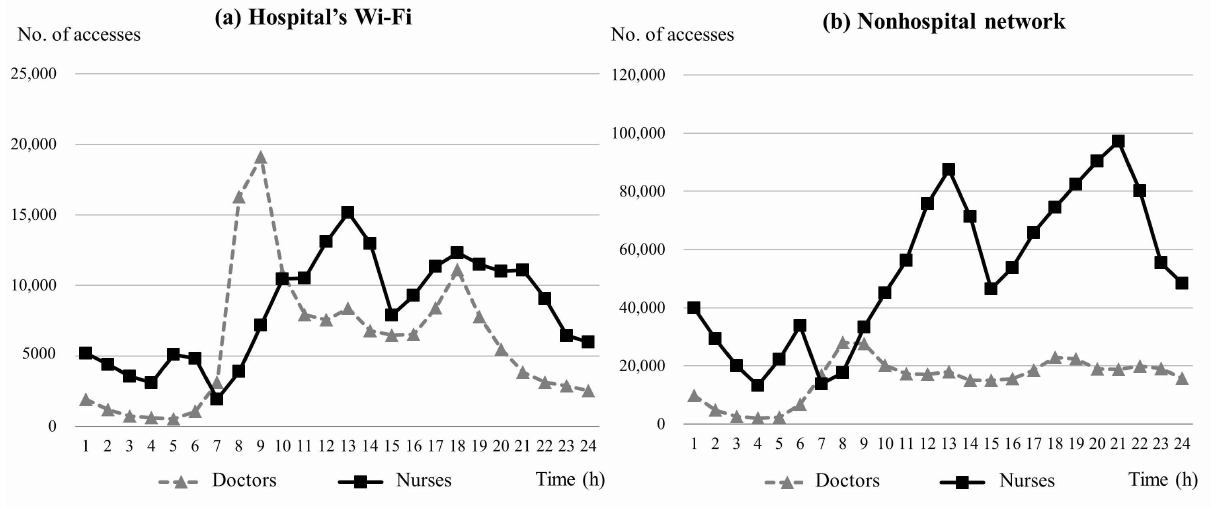
Figure 5. Network access frequency according to time and user’s occupations for (a) hospital’s Wi-Fi, and (b) a nonhospital